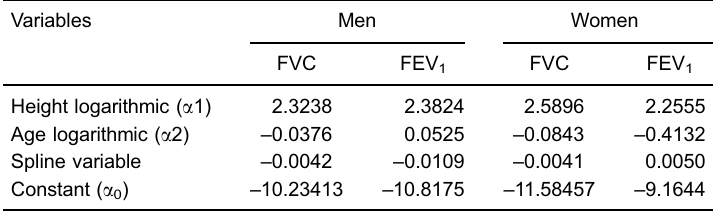
Figure 3. Results of the Bland-Altman test in the forced vital capacity (FVC) in men. Ru fi no et al. is the present study. Table 4. FVC and FEV 1 (L) spline